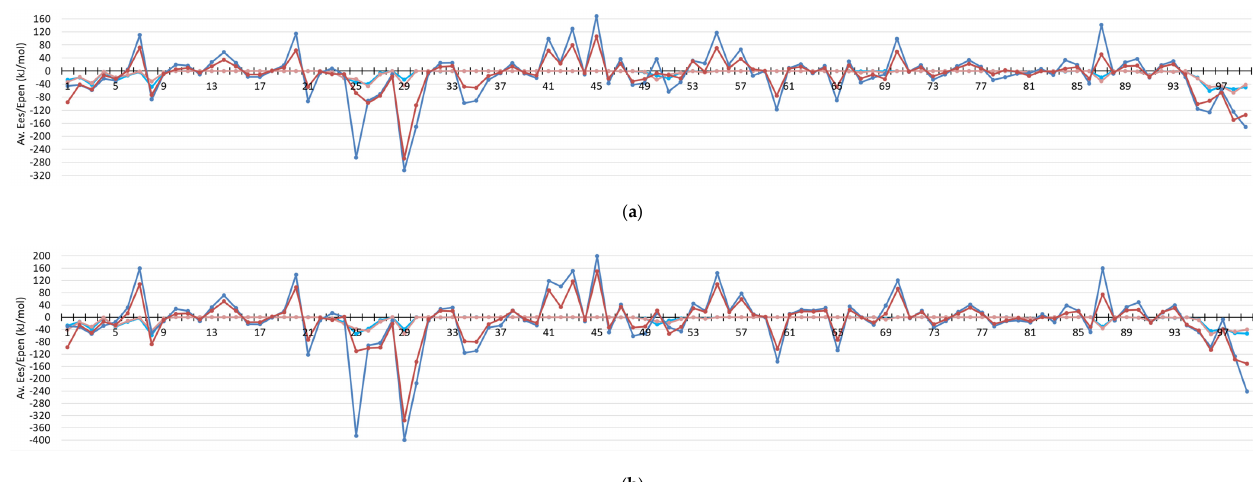
Figure 4. Averaged electrostatic interaction energies (Ees) and penetration contributions to them (Epen) for interactions of a residue from one monomer with all residues of the other monomer for 1KZK ( a ) and 4DQB ( b ) structures. Ees: dark blue—monomer A; dark red—monomer B. Epen: light blue—monomer A; light red—monomer B.